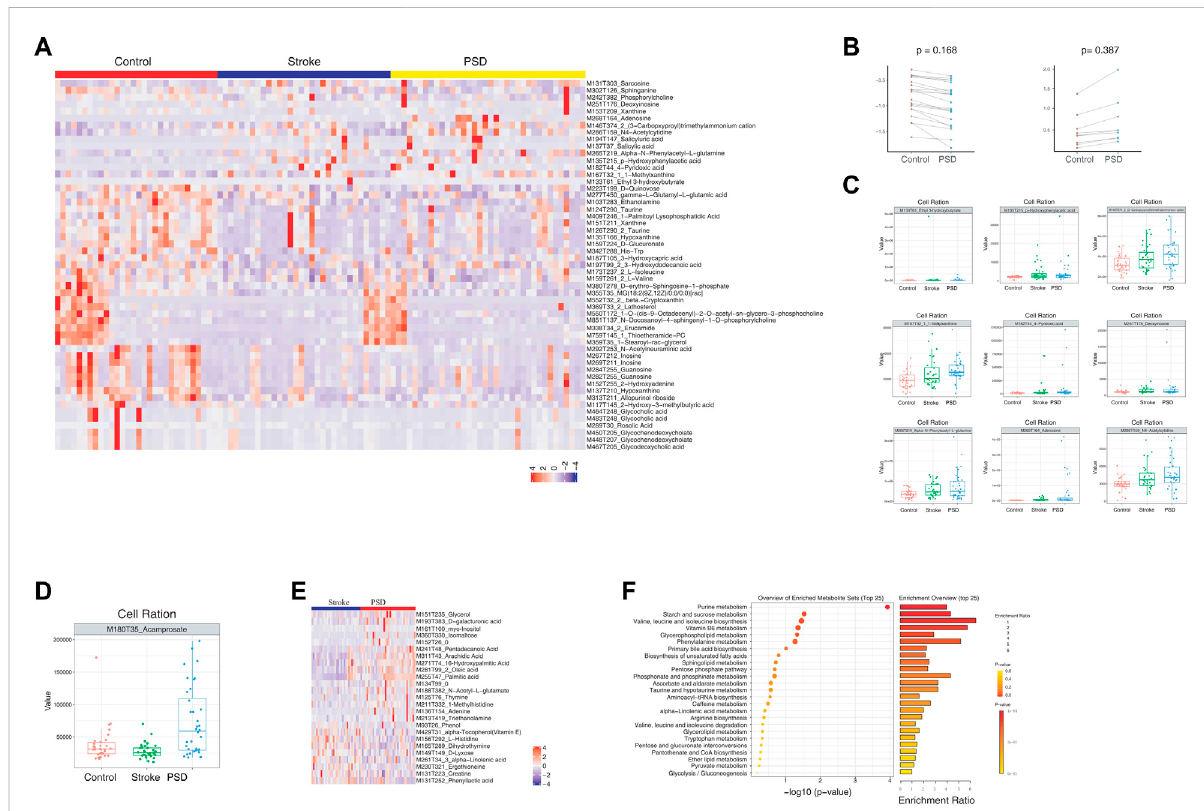
Atlas of abnormal blood metabolism in patients with PSD. (A) . Heatmap depicting abnormal metabolites common to stroke and PSD patients. (B) . Paired scatterplot depicting continuous changes in total abnormal metabolites. (C) . Box plot depicting abnormal metabolites that continue to increase during the process from control-stroke-PSD. (D) . Box plot depicting abnormal metabolites associated with excessive recovery during the process from control-stroke-PSD. (E) . Heatmap depicting differences in metabolites between stroke and post-stroke depression patients. (F) . Metabolic pathwayenrichment analysis. (G) . Network diagram depicting genes (circles) and metabolites (squares). The size of thedot represents the degree value. (H) . KEGG global metabolic network depicting differentially expressed genes and differential metabolites between PSD and